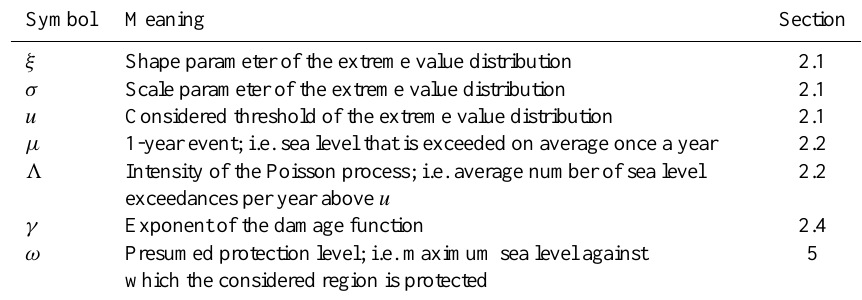
Table 1. Overview of employed symbols, their meanings, and section in which they are introduced. Symbol Meaning Section ξ Shape parameter of the extreme value distribution 2.1 σ Scale parameter of the extreme value distribution 2.1 u Considered threshold of the extreme value distribution µ 1-year event; i.e. sea level that is exceeded on average once a year (cid:51) Intensity of the Poisson process; i.e. average number of sea level